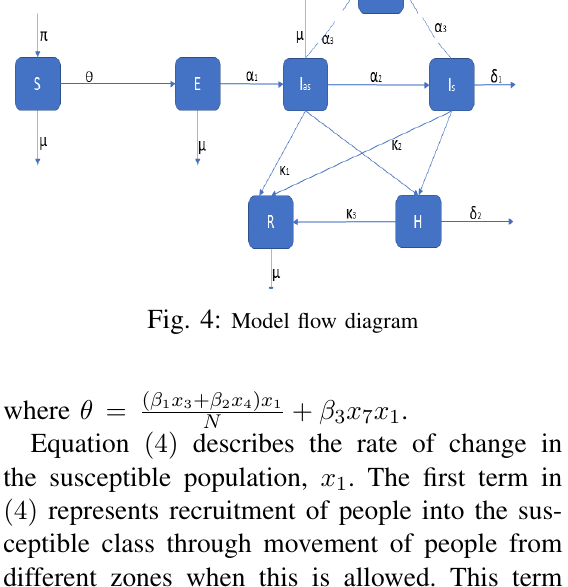
where θ = ( β 1 x 3 + β 2 x 4 ) x 1